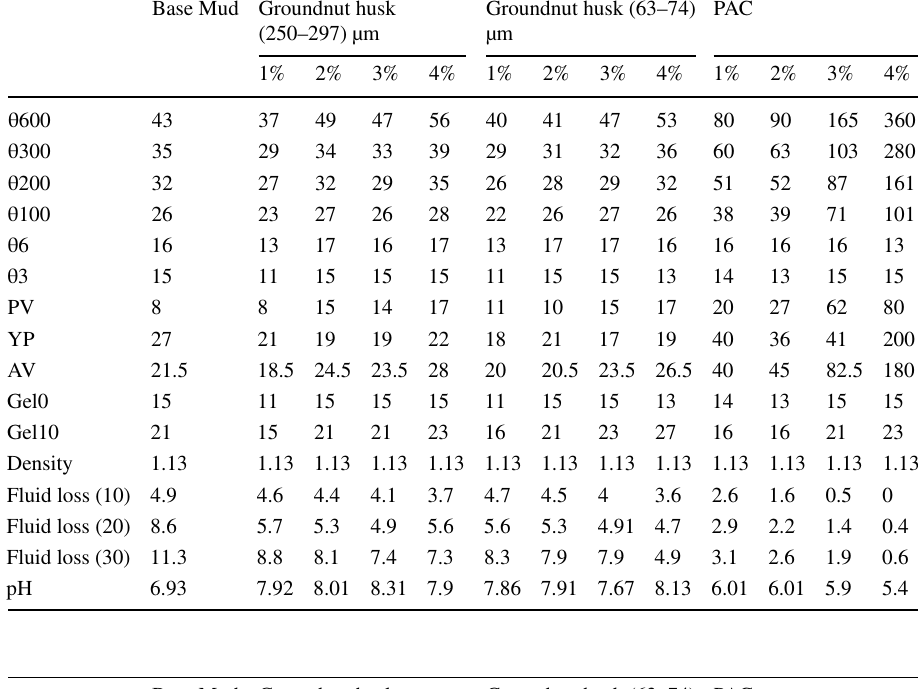
Base Mud Groundnut husk (250–297) µm